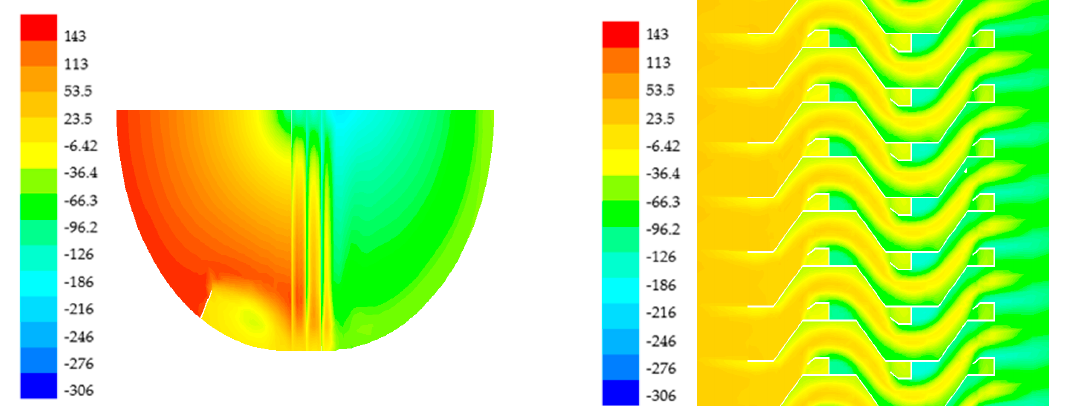
Figure 4. Total pressure distribution in different section, Pa. ( a ) Longitudinal section. ( b ) Cross section.